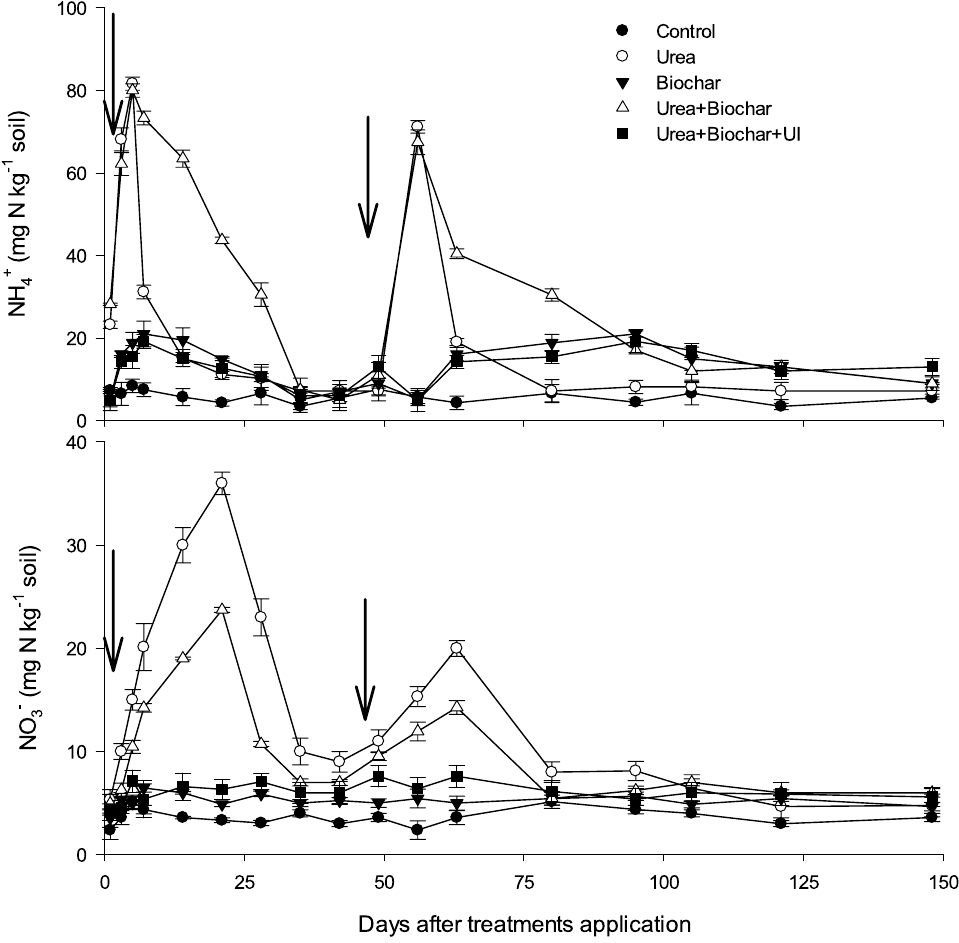
Figure 1. Soil NH 4 + and NO 3 − contents as affected by nitrogen application with and without biochar and/or urease inhibitor. Bars on means represent SE for n = 4. The arrows show time of N